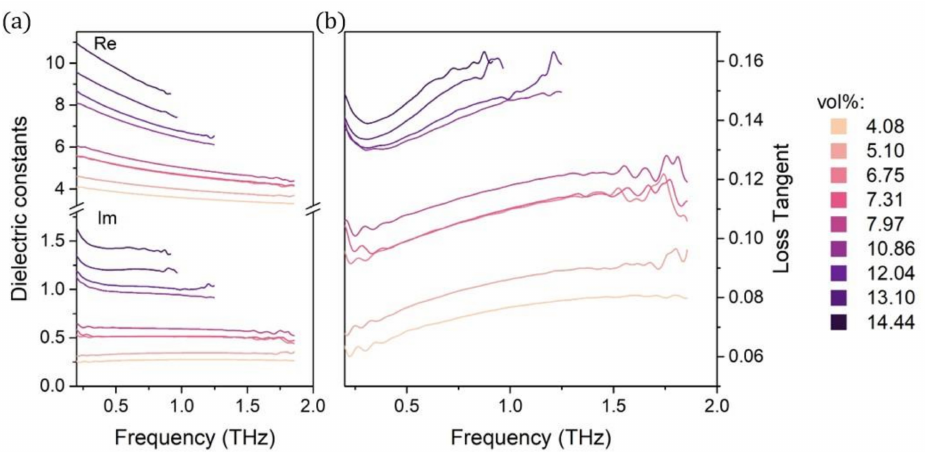
Figure 5. Dielectric properties of fabricated composites: ( a ) real and imaginary parts of the dielectric permittivity; and ( b ) the calculated loss